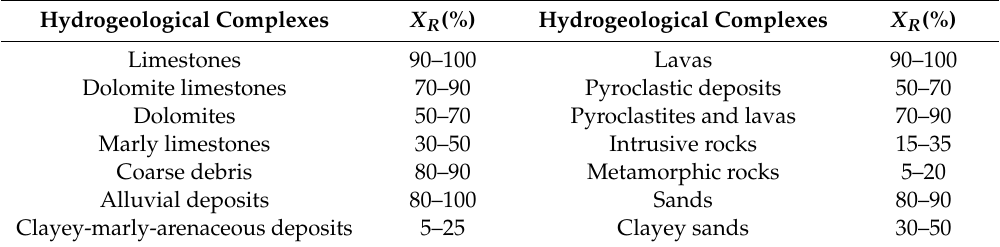
Table 1. Main hydrogeological complexes and relative potential infiltration coe ffi cients [57].